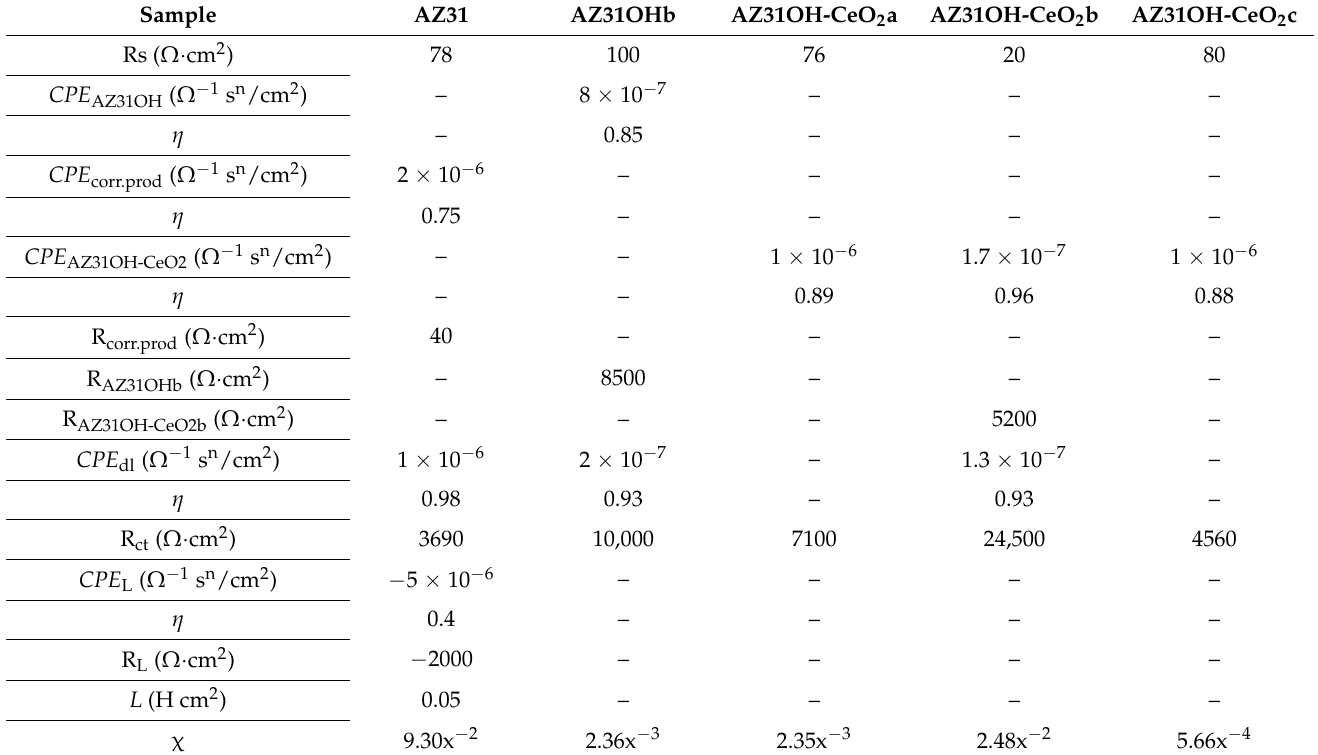
Table 5. Electrochemical data obtained from equivalent circuit fitting of EIS graphs in Figure